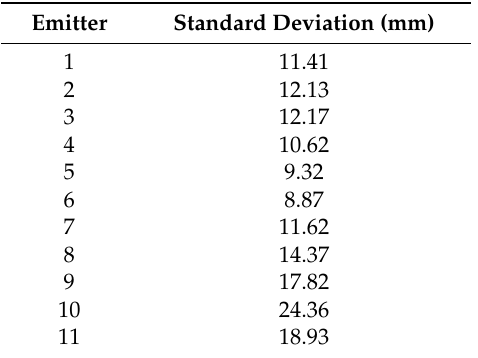
Table 1. Emitters mean standard deviation